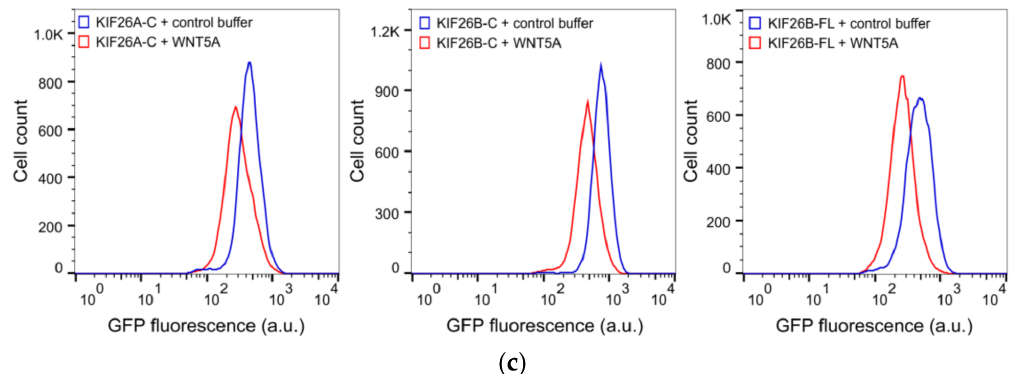
Figure 1. The C-terminus of KIF26B is sufficient and required for WNT5A-dependent degradation. ( a ) Truncation analysis of KIF26B degradation activity in full length KIF26B (FL) and combinations of N-terminal (N), motor-like (M) and C-terminal (C) domains. Each truncated construct was fused to GFP, stably transfected into NIH/3T3 cells and tested for its ability to undergo degradation after WNT5A stimulation (200 ng/mL WNT5A for 6 h) of the reporter cells; ( b ) Quantification of reporter activity for each truncation variant shown in ( a ). Error bars represent ± standard error of the mean (SEM) calculated from three replicates. Statistical analysis was performed with unpaired t -test ( n.s. = not significant; ** p value < 0.01; *** p value < 0.001 vs. GFP-FL); ( c ) Flow cytometry histograms depicting